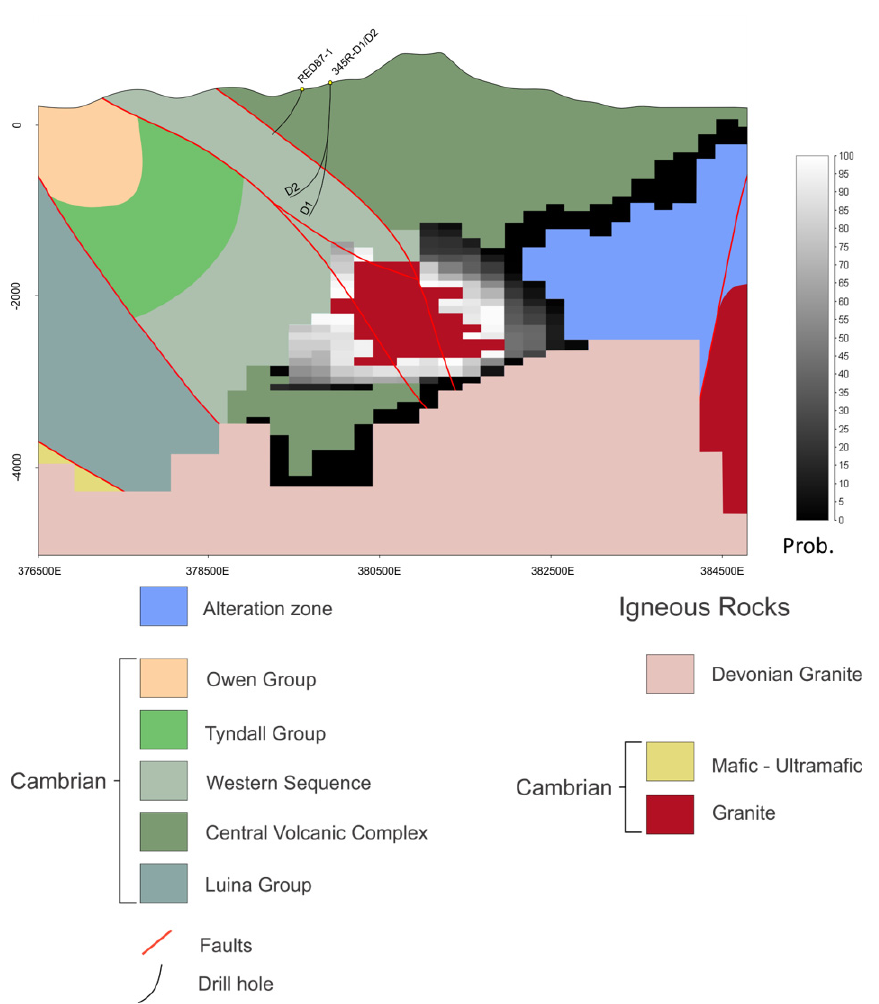
Figure 19. East–west cross-section intersecting residual magnetic anomaly at N 5377182 and illustrating the most probable threshold model geology. Greyscale legend shows the probability of Cambrian Granite and model-informed alteration zone